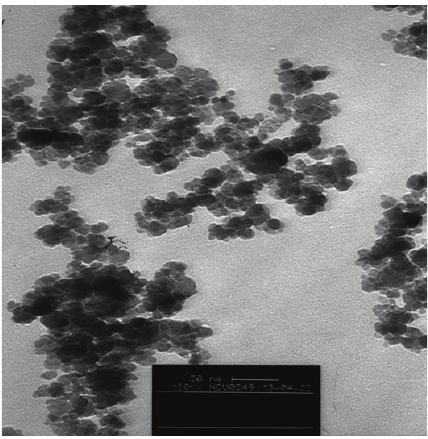
Figure 1: The TEM image of the synthesized MNP s , magnification 160000.